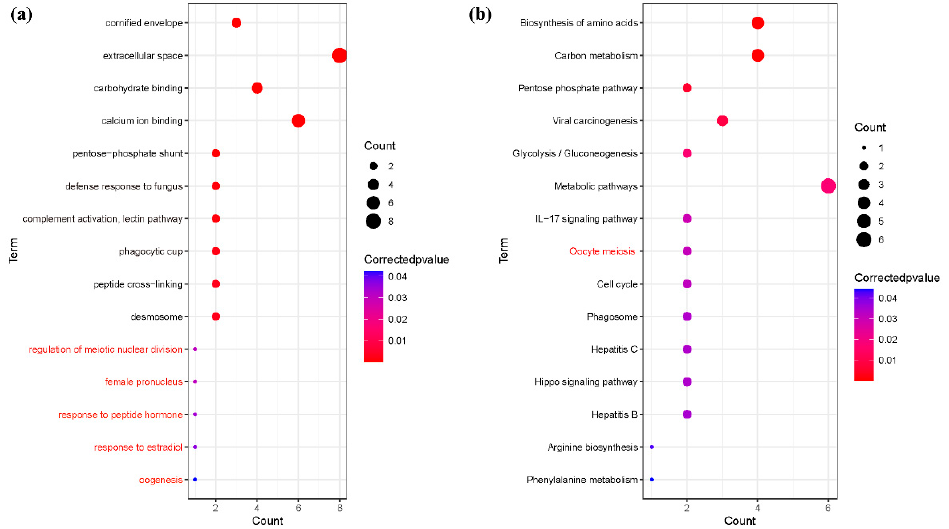
Figure 6. Functional enrichment analysis of different proteins in the saliva of Large White sows. ( a ) GO enrichment analysis of salivary differential proteins during the estrus cycle. ( b ) Enrichment analysis of salivary differential protein KEGG pathway during the estrus cycle.